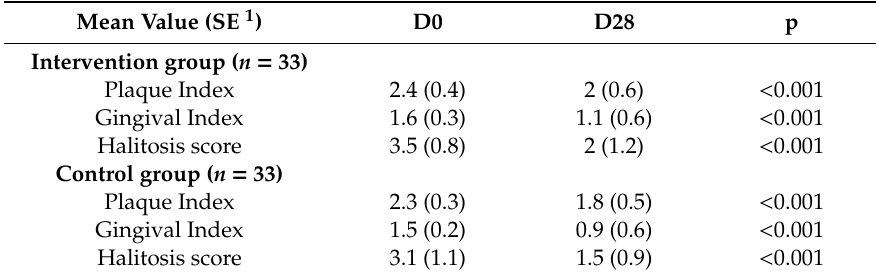
Table 3. Comparison of oral clinical parameters from baseline (D0) to the end of the study